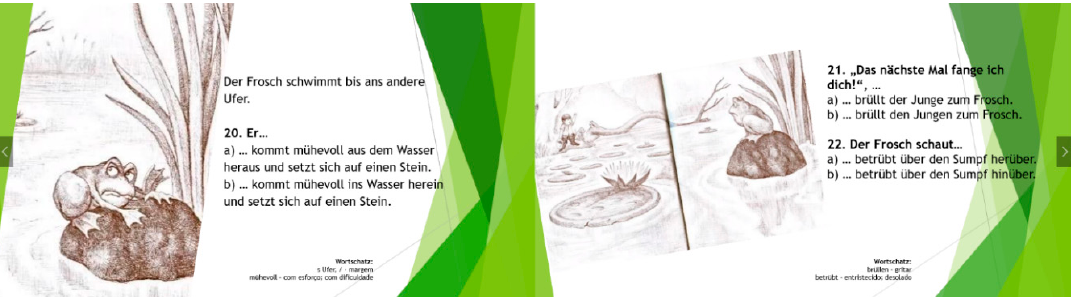
Figure A21. Pretest: Binary-choice recognition task.